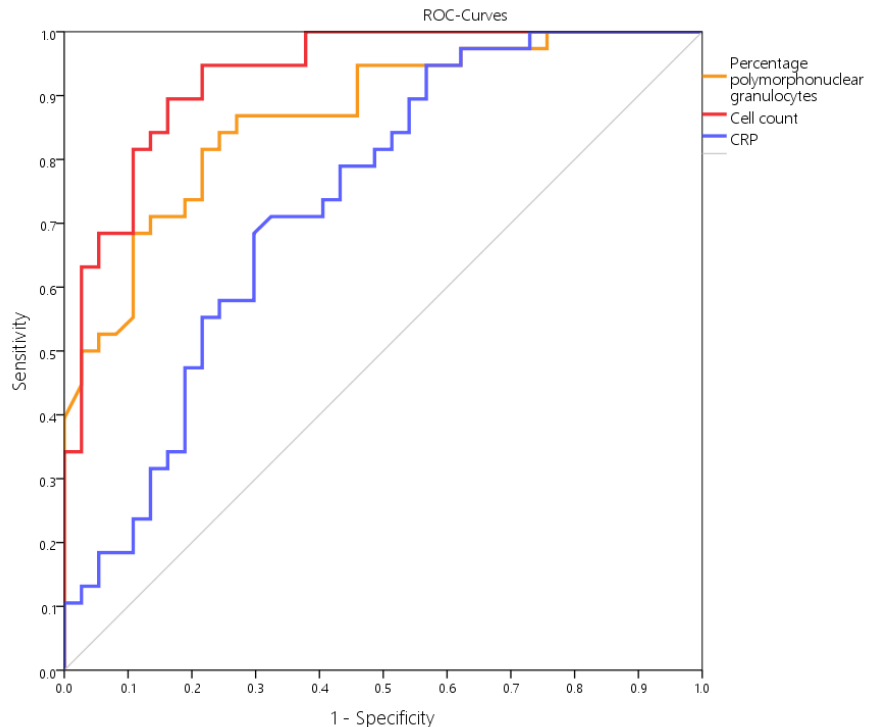
Figure 6. ROC curves of the parameters cell count, percentage PMN, and CRP. Area under the curve (AUC) was 0.932 for cell count, 0.868 for %PMN, and 0.734 for CRP.